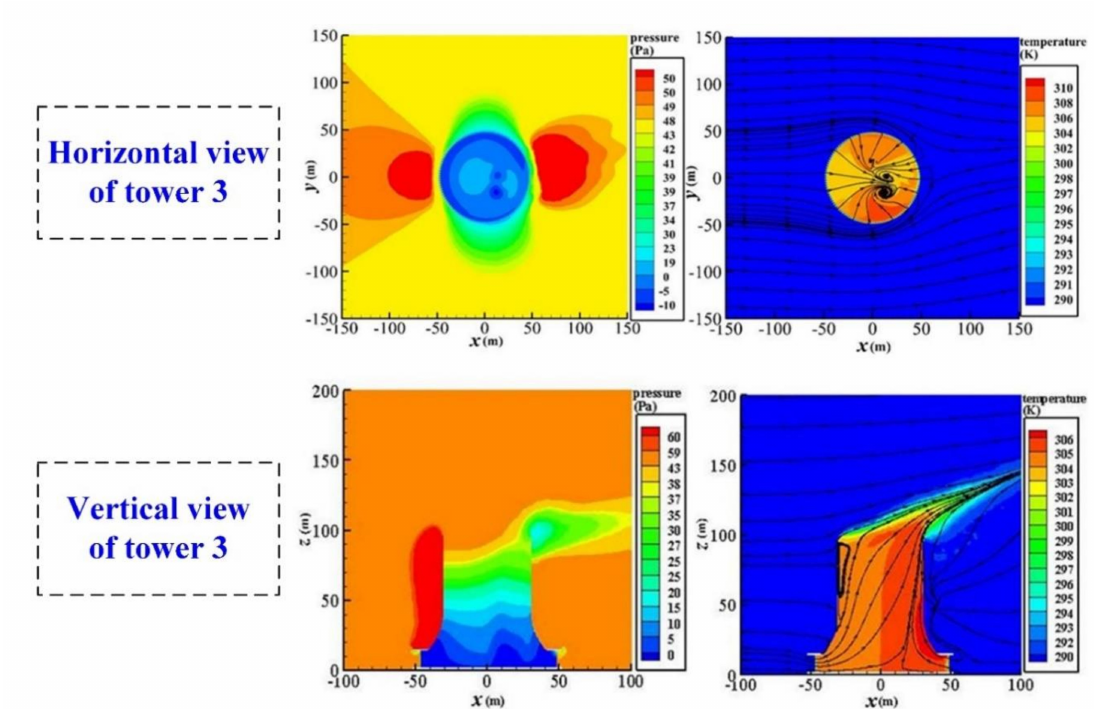
Figure 12. Air variable contours for steel-truss NDDCS with hyperbolic/cylindrical tower configuration at design crosswind of 4 m/s.